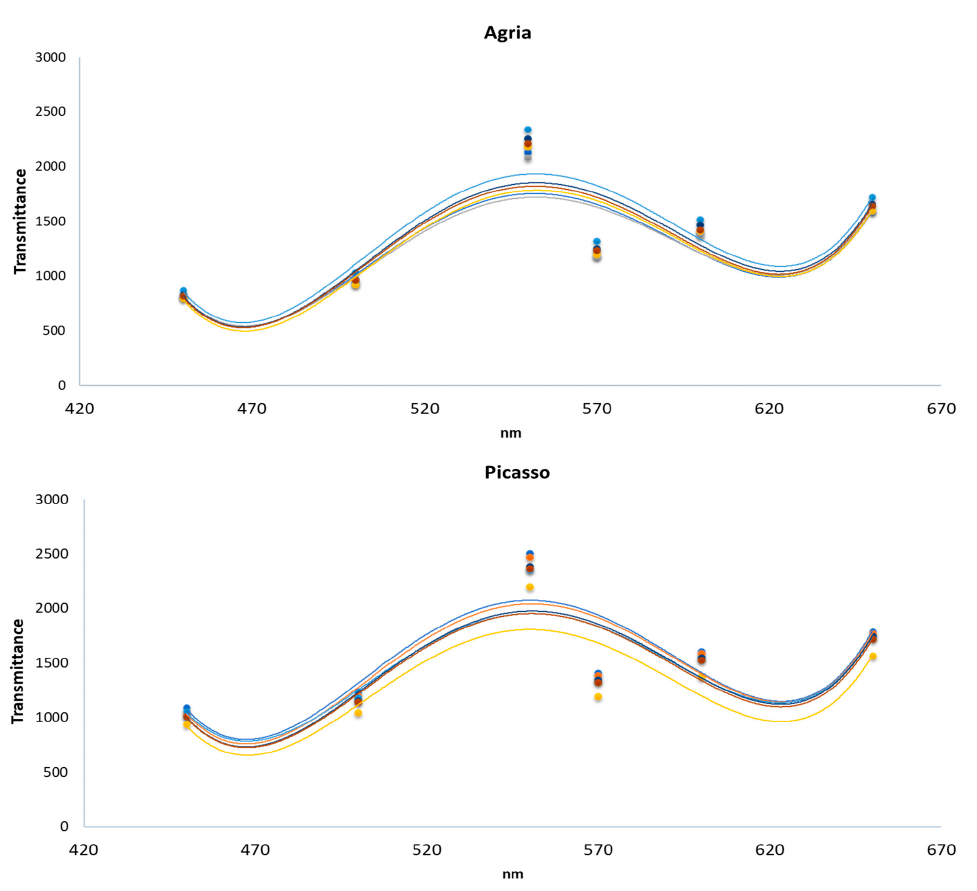
Figure 4. Visible spectra showing the average of transmittance ( n = 3) in tubers of S. tuberosum varieties (Agria, Picasso and Rossi), at harvest ● Control, ● 0.5 kg ha − 1 Ca(NO 3 ) 2 , ● 2 kg ha − 1 Ca(NO 3 ) 2 , ● 4 kg ha − 1 Ca(NO 3 ) 2 , ● 3 kg ha − 1 CaCl 2 and ● 6 kg ha − 1 CaCl 2 ).